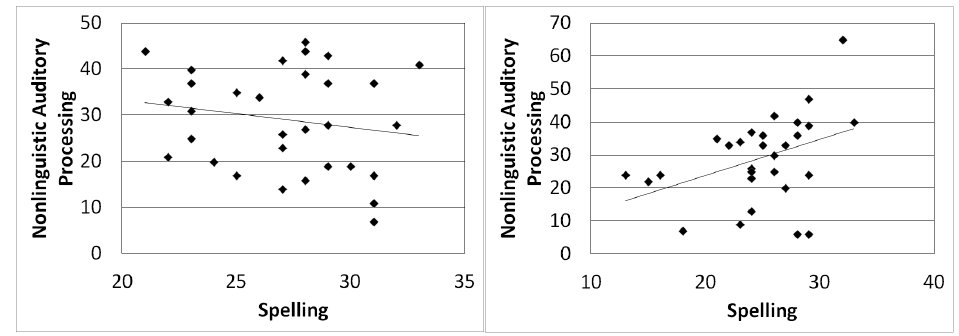
Figure 5. Correlation between nonlinguistic auditory processing accuracy and spelling ability among nonphonological spellers, r (29)= 2 .179, p = .335 (left), compared with correlation between nonlinguistic auditory processing accuracy and spelling ability among phonological spellers, r (29)= .385, p = .032 (right).